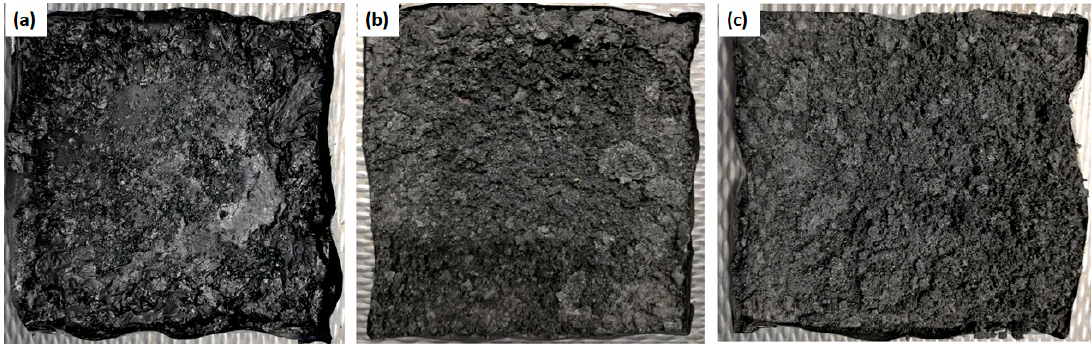
Figure 10. Char residues of fabric samples ( a ) 1% KL ( b ) 3% KL ( c ) 5% KL after cone calorimetry.